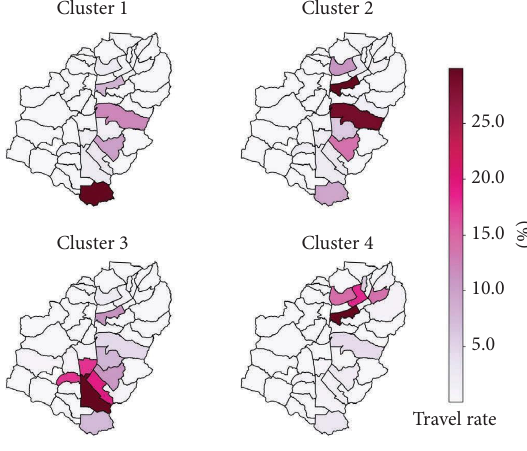
Figure 4: Results of GMM